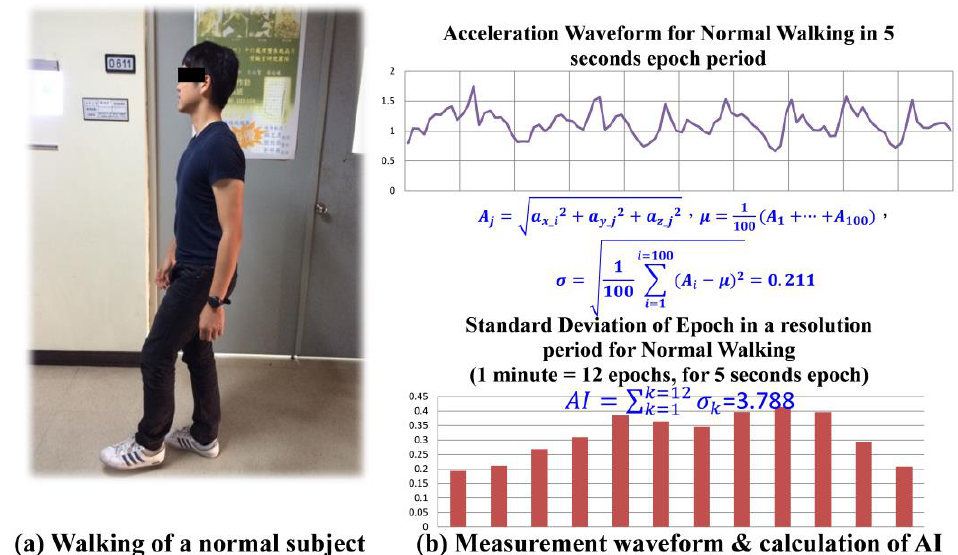
Figure 2. ( a ) Photo of walking test and ( b ) acceleration waveform of measured activity and calculation of AI.